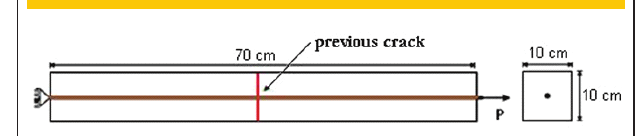
Figure 4 – Maximum displacement curve versus